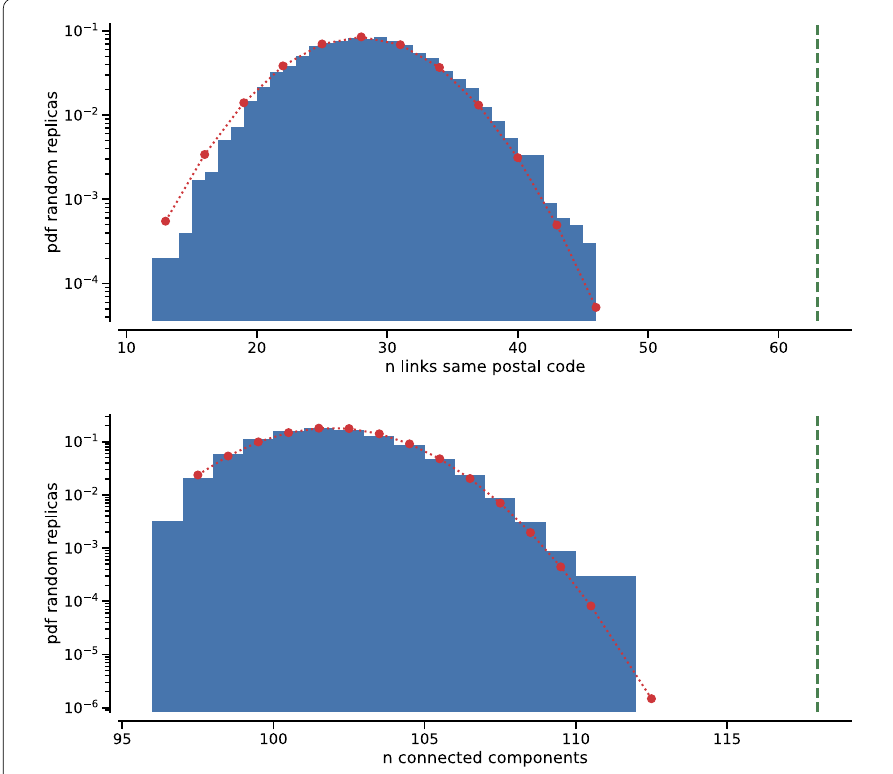
Figure 3 ( a ) The green dashed vertical line shows the number of links between members resident in the same postal code in the original network (63). The blue bars show the the distribution of the same quantity extracted from an ensemble of random replicas of the network that preserve the degree distribution.( b ) The green dashed vertical line shows the number of connected components obtained after removing links between affiliates resident in different postal codes in the original network. The blue bars show the the distribution of the same quantity obtained removing the same number of randomly selected links. For both panels, the random distributions are obtained over 10,000